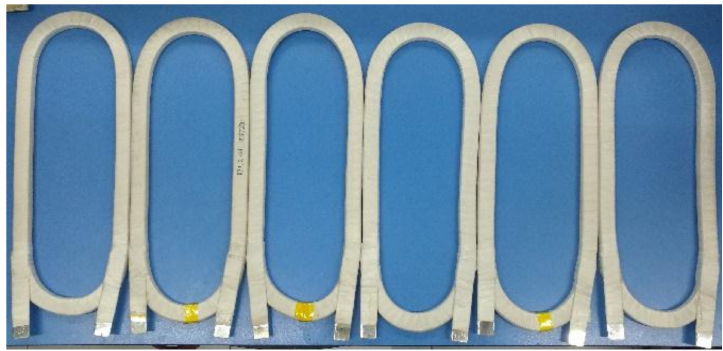
Figure 15. The fabricated HTS racetrack-shaped coils with the insulation material.